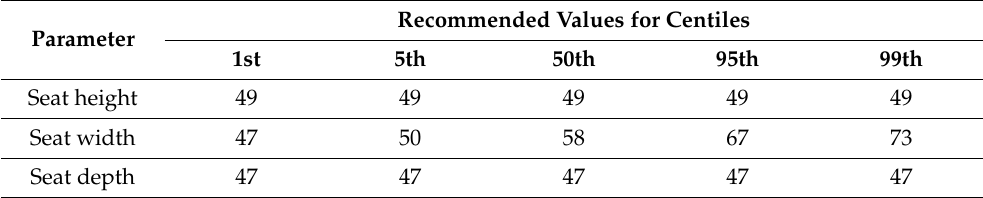
Table 3. Recommended dimensions of a wooden chair for bariatric